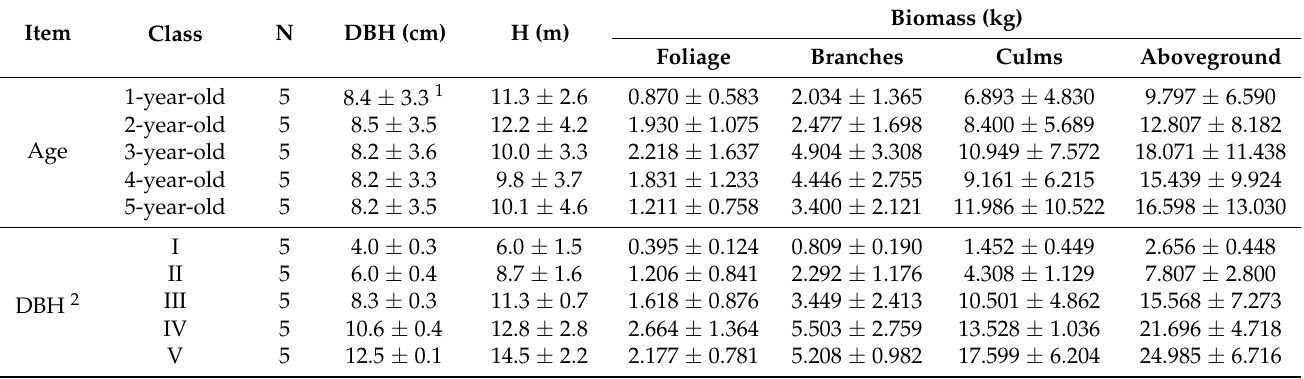
Table 2. The distribution of the diameter at breast height (DBH), culm height (H) and biomass of different sections of age and DBH classes in Ma bamboo